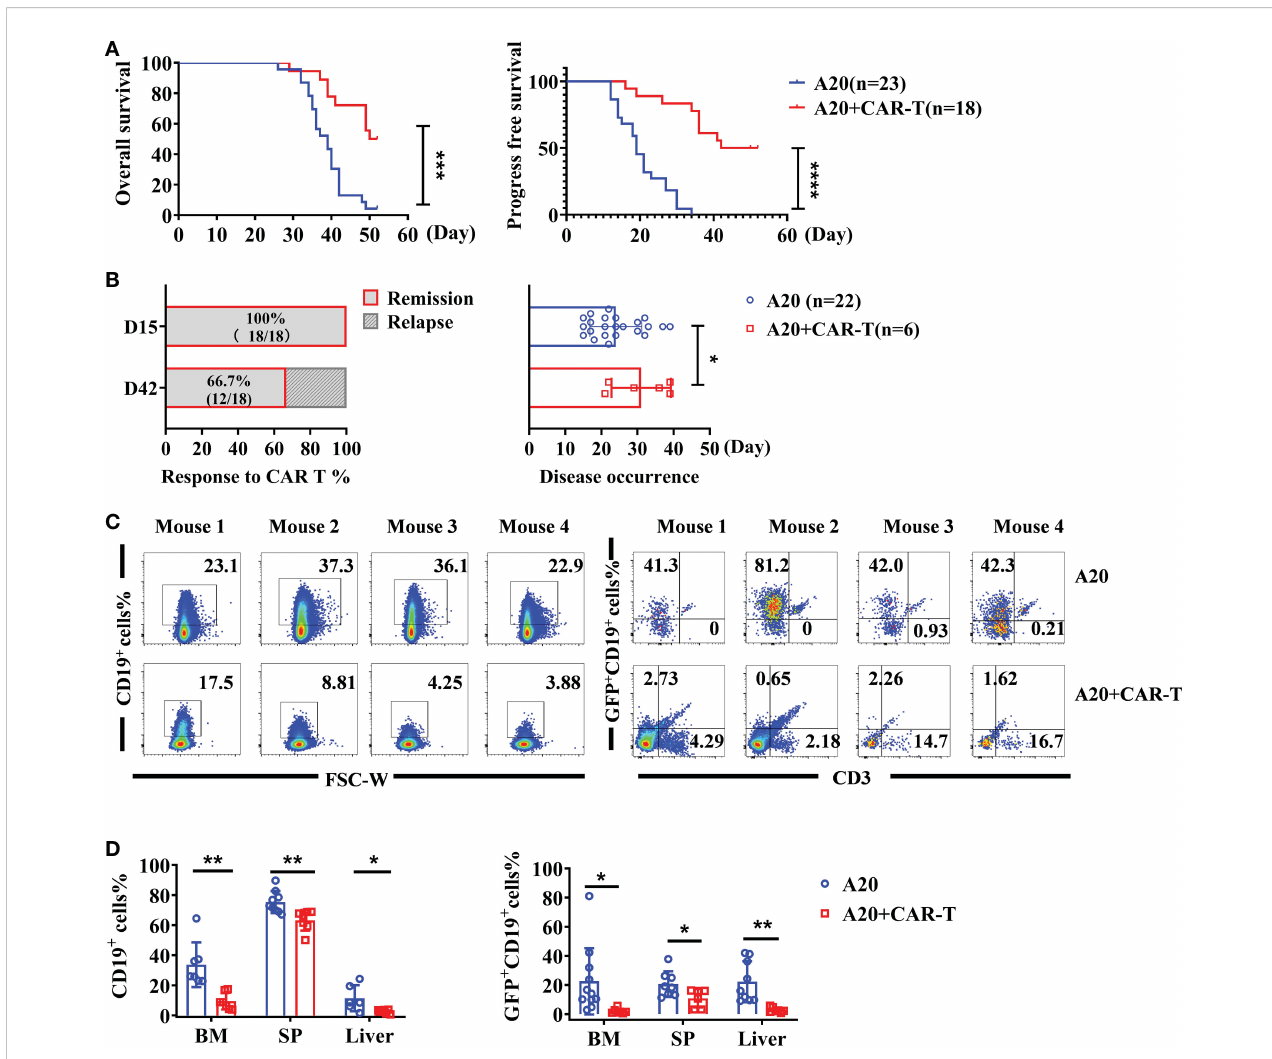
FIGURE 2 The effect of anti-CD19 CAR-T administration. (A) The survival of lymphoma mice. The OS and PFS data were recorded on the day of the CAR-T-cell injection. (B) The response rate after anti-CD19 CAR T-cell therapy and the time of disease occurrence were shown. (C) The percentage of total CD19 + cells and GFP + CD19 + cells (A20) of BM and liver on day 15. The representative fl ow cytometry plots were shown for four individual mice. (D) The statistics data for CD19 + cells and A20 cell percentage (n = 8 or 12). Survival was compared using the log-rank test, and the t-test was used to compare between two groups. There were two independent experiments that were repeated. * P < 0.05, ** P < 0.01, *** P < 0.001, **** P <